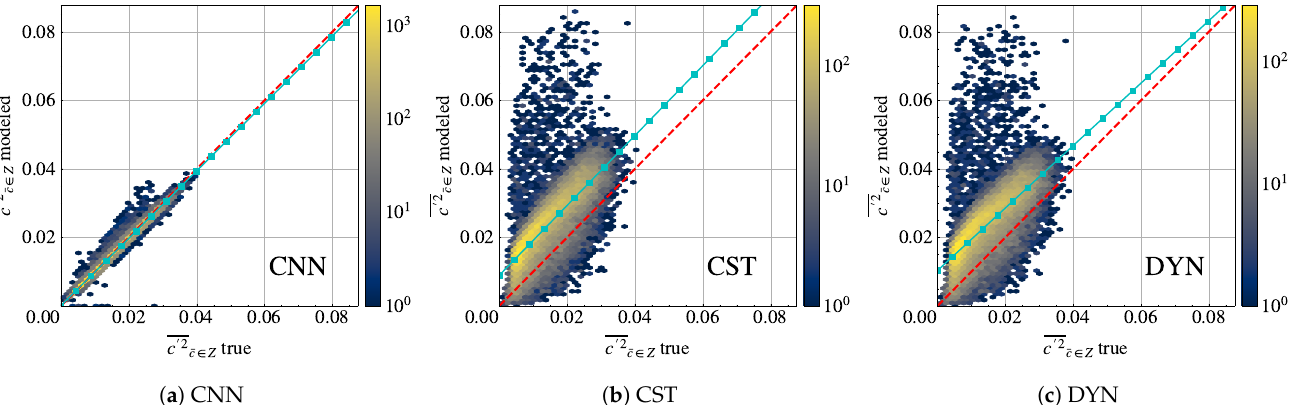
: ( a ) CNN model, ( b ) CST model, ∈ Z